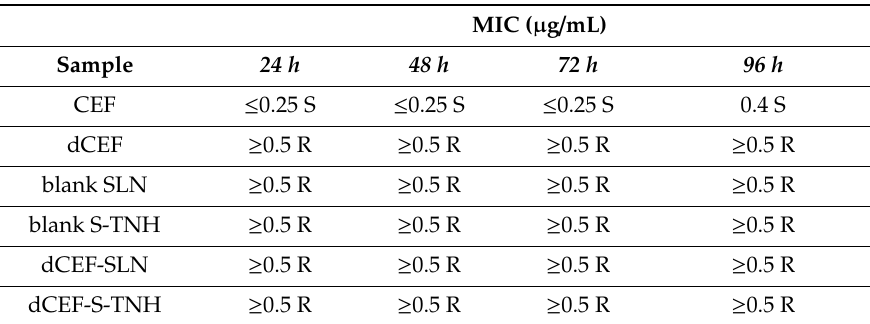
Table 5. MIC test